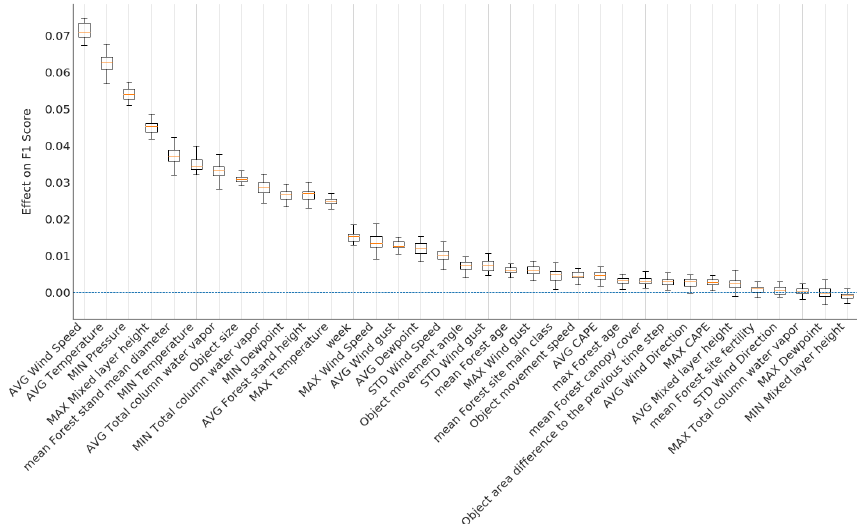
Figure 7. Permutation feature importance using the GP classification method trained with the randomly selected national dataset. The higher the effect on the F1 score ( y axis), the bigger the